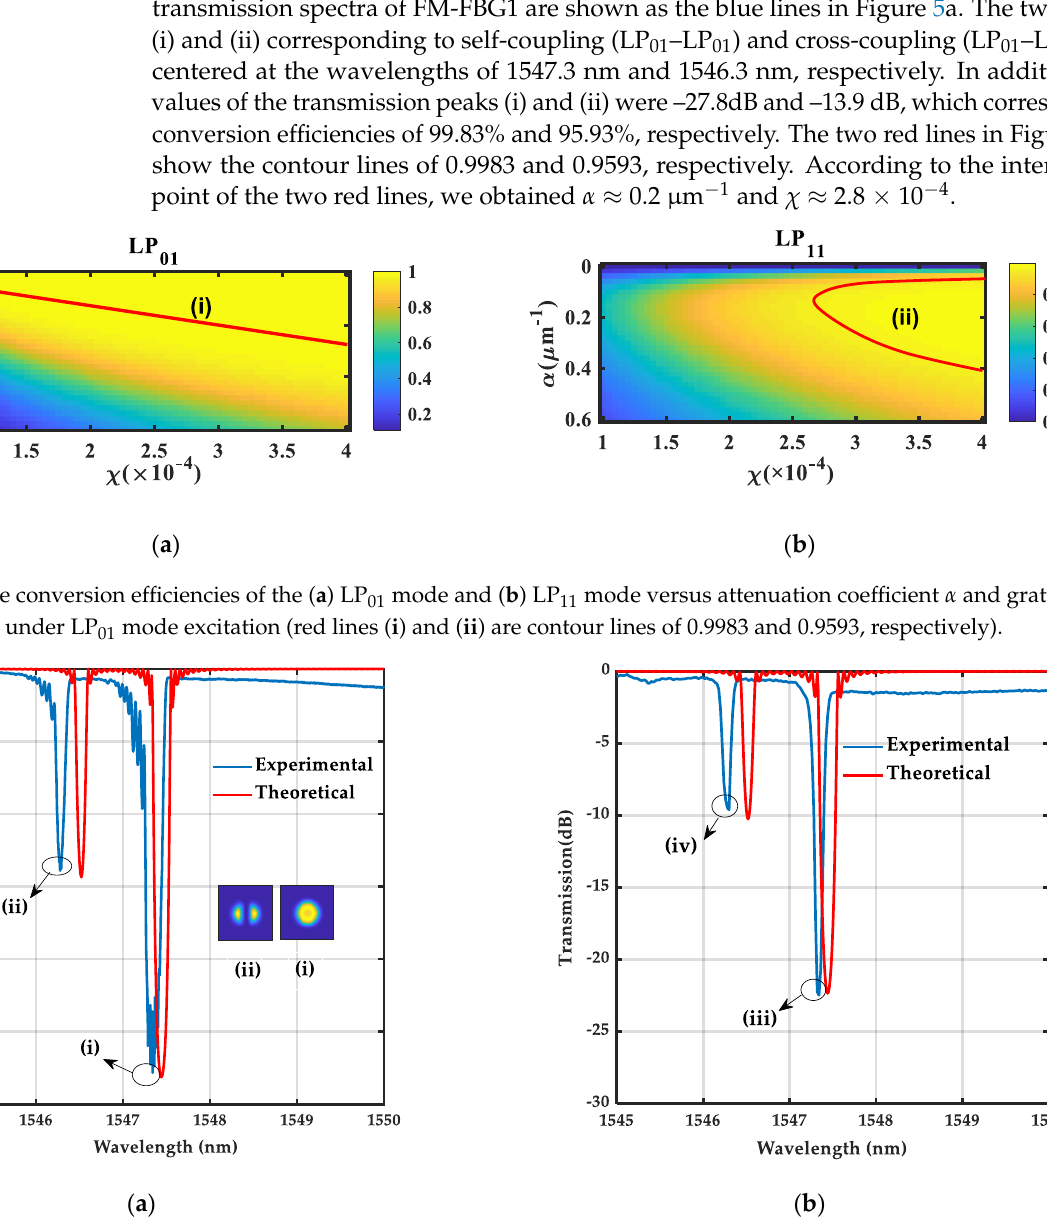
Figure 5. Theoretical and experimental results of the transmission spectra of ( a ) FM-FBG1 and ( b ) FM-FBG2 under LP 01 mode